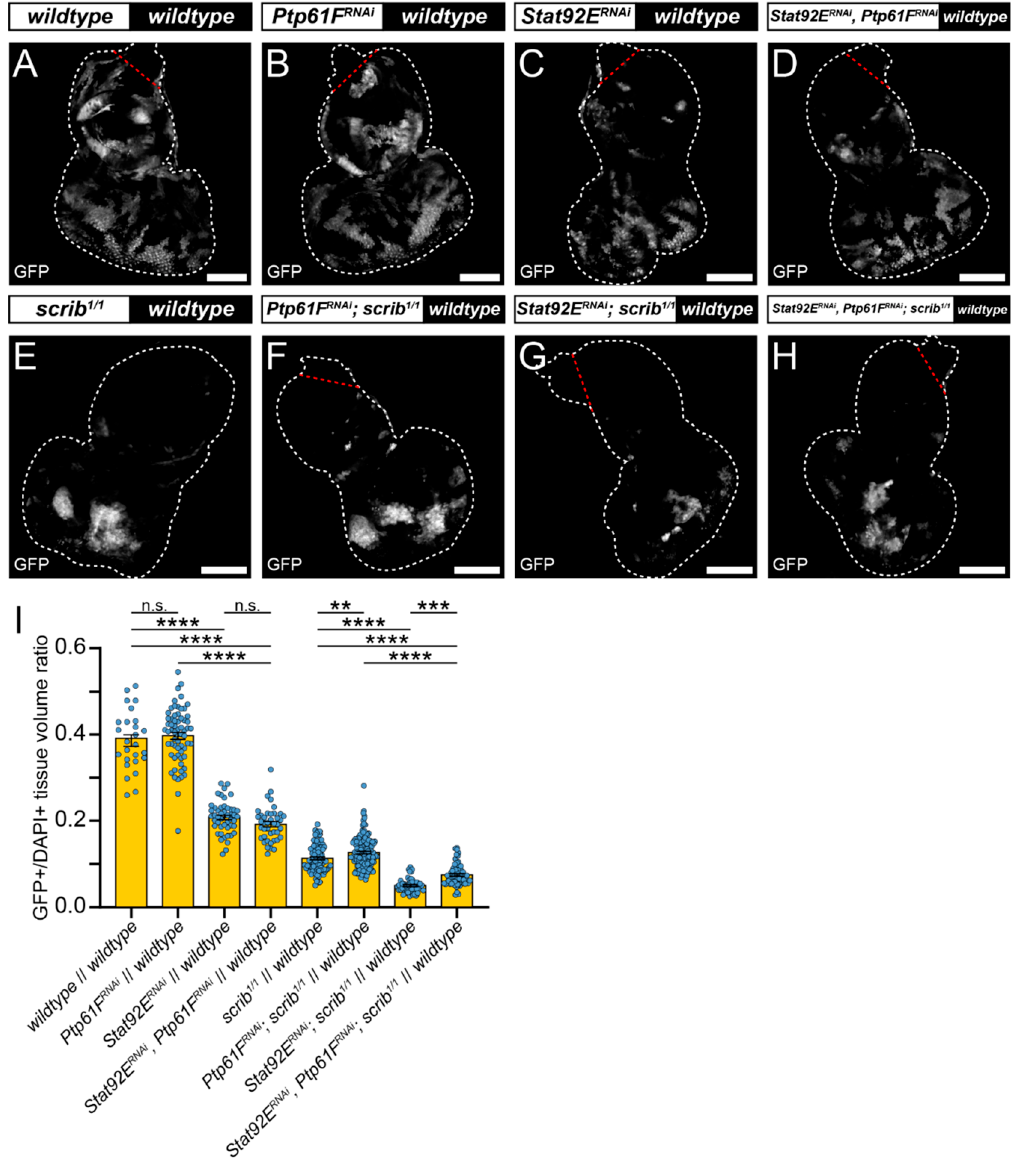
Figure 3. Stat92E is required for rescue of scrib -mutant clone size by Ptp61F knockdown. ( A – H ) Confocal images of L3 eye-antennal imaginal discs of the indicated genotypes (boxes at top, white indicates GFP-positive clones, black indicates remaining GFP-negative tissue) taken from animals where clones were generated via MARCM to express transgenes in GFP-